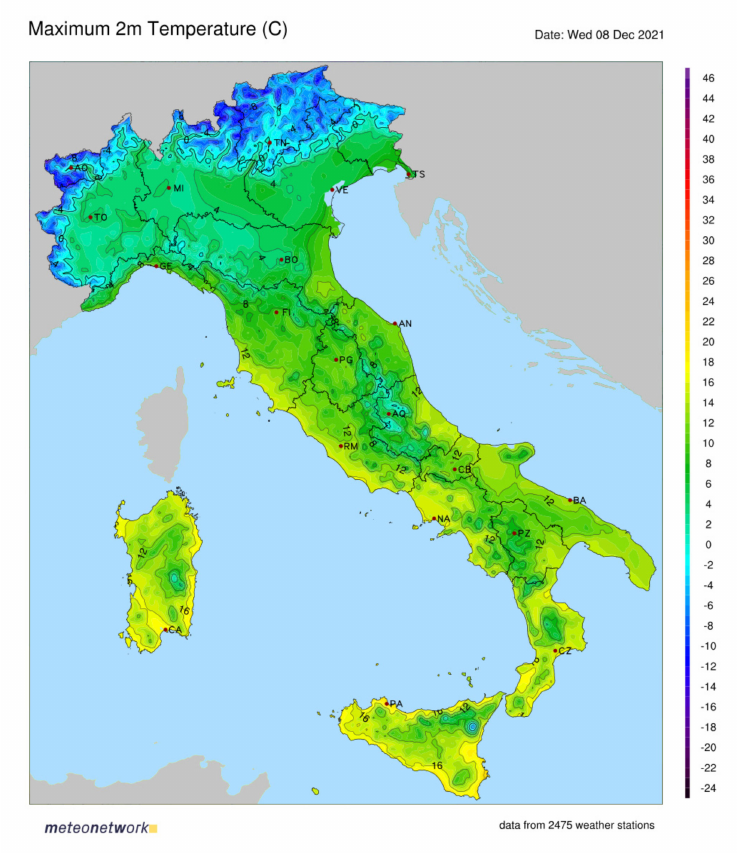
Figure 5. An example of a daily map for the maximum air temperature ( ◦ C) at 2